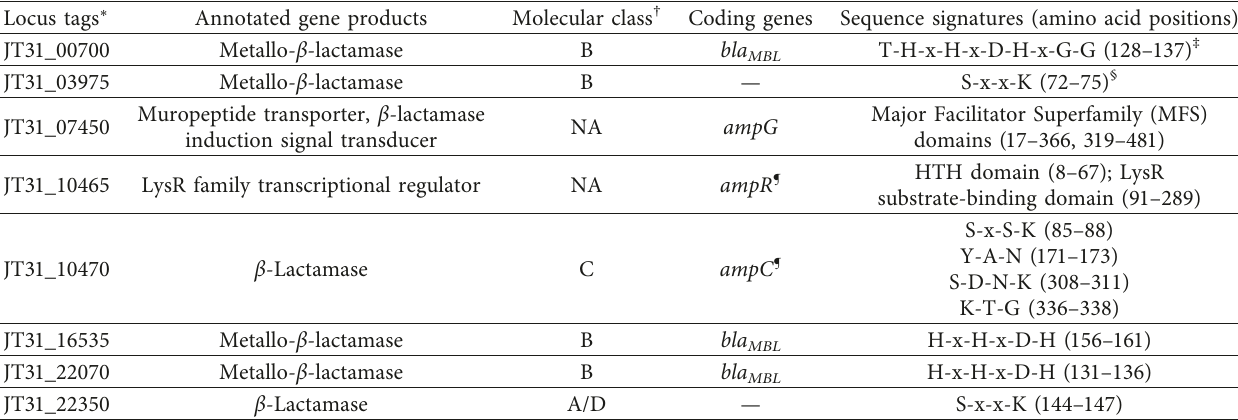
Table 3: β -Lactamases and other β -lactam resistance proteins encoded in the Cedecea neteri SSMD04 genome. Locus tags